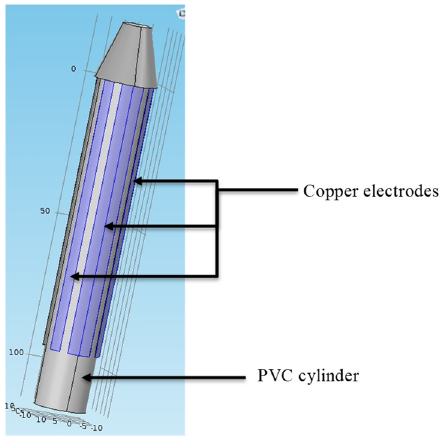
Figure 11. Branches sensor shape.